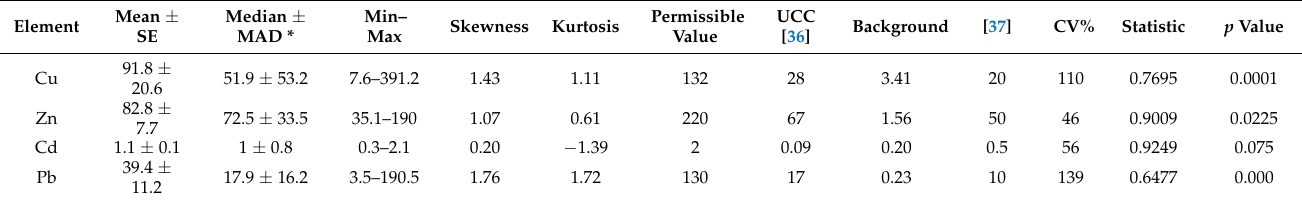
Table 2. Descriptive statistics of the obtained results in